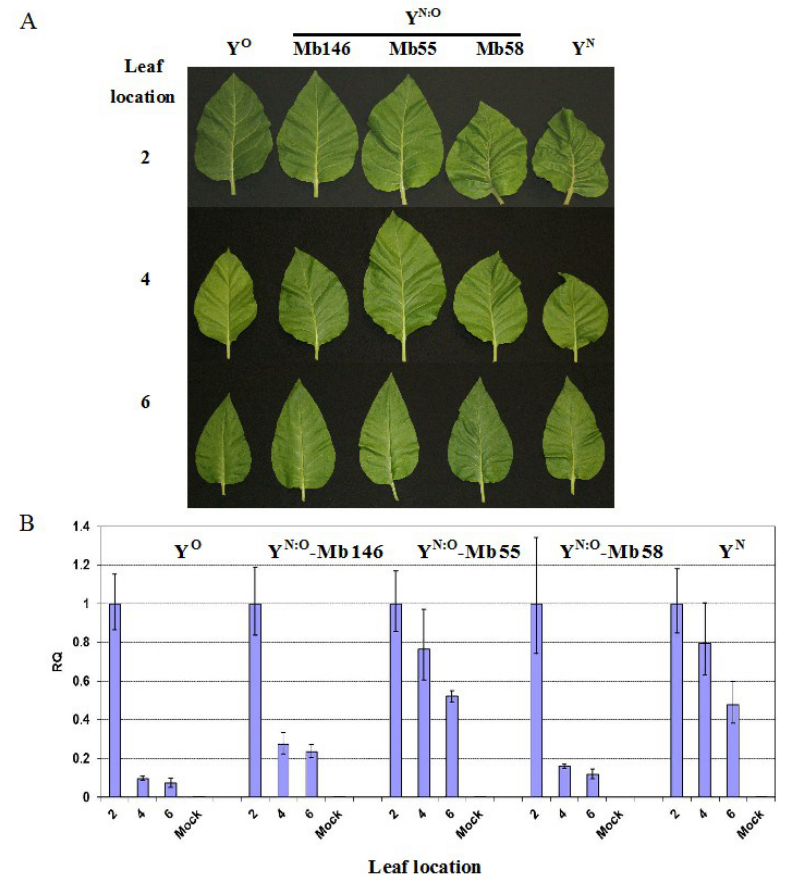
Figure 3. Symptoms and virus level in leaves of tobacco plants infected with different strains/isolates of PVY. ( A ) Symptoms in +2, +4 and +6 leaves of plants infected with PVY O (Y O , isolate RB), PVY N:O (Y N:O , isolates MB146, Mb55 and Mb58) and PVY N (Y N , isolate N-Jg) at the leaf age of 12 days post-emergence; ( B ) Relative PVY level (RQ) in leaves. The virus level was obtained using real-time RT-PCR analysis of PVY upon normalization with COX1 level in the